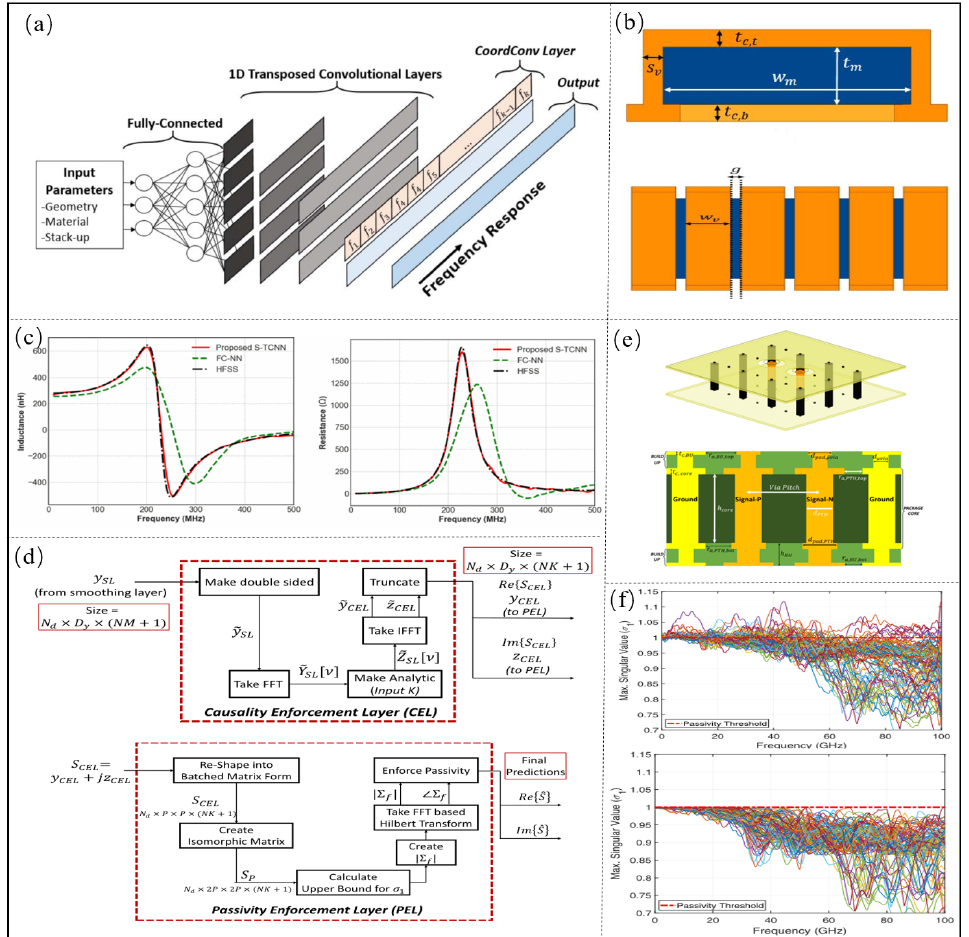
Figure 6. ( a ) Proposed S-TCNN architecture. Adapted with permission from [74]. ( b ) Geometry of the solenoidal inductor. Adapted with permission from [74]. ( c ) Comparison of S-TCNN and FC-NN to EM simulations. Adapted with permission from [74]. ( d ) Block diagram summary of the operations performed in CEL and PEL. Adapted with permission from [75]. ( e ) Geometry of the differential PTH structure. Adapted with permission from [75]. ( f ) Passivity characterization of the predicted S-parameters. Adapted with permission from